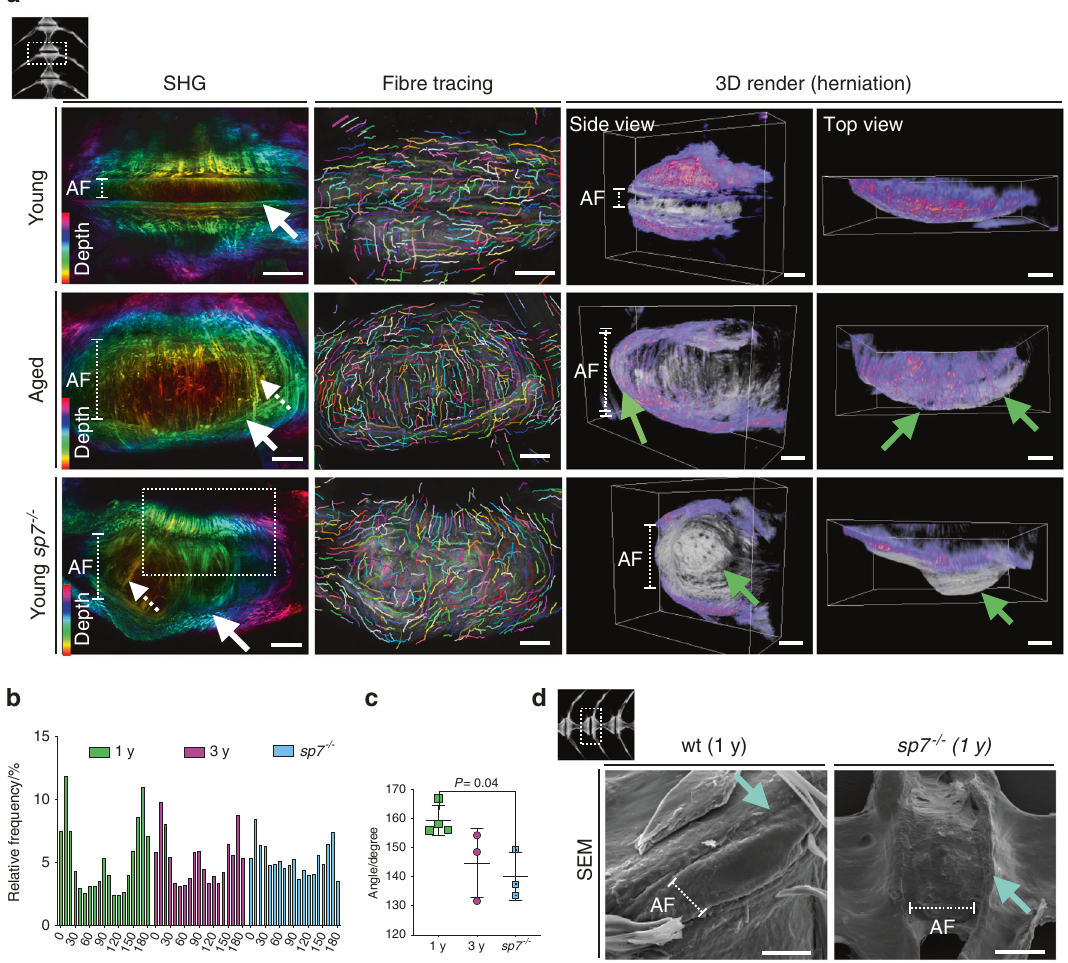
Fig. 6 Altered collagen fi ber organization and disc herniation in zebra fi sh IVDD. a Max projection of image stacks from second harmonic generation (SHG) imaging color coded by depth. Individual collagen fi ber was traced using CTFire. 3D volumetric rendering from SHG images were used to visualize disc herniation in 3D using Amira (gray = back-scatter SHG; purple = forward-scatter SHG). Orientation of the vertebral column is shown at the top left of the panel. The annuls fi brosus (AF) is indicated with a dashed line. Note the variation in AF length among the groups. Smooth perpendicular fi ber organization at the endplate was observed only in young samples (white arrow, SHG). Thicker fi bers were observed in the AF of aged and sp7 − / − zebra fi sh (dashed arrow). Bulging discs were found in aged zebra fi sh and severely bulging discs were found in sp7 − / − zebra fi sh (green arrows, 3D render). Scale bars = 50 μ m. b Relative frequency distribution (%) of angles of collagen fi bers from each group. The graph was generated in Prism 8. c Angle of the most common collagen fi bers (75% of total fi bers) show abnormal orientation in sp7 − / − fi sh ( n = 3 fi sh per group). One-way ANOVA, post hoc Tukey ’ s multiple comparisons test; data are the mean and SD. P values are indicated when signi fi cant ( P < 0.05). d Scanning electron microscopy (SEM) of 1-year-old wt and sp7 − / − zebra fi sh (1 y). Note a smooth transition from the vertebral bone to the AF in wt zebra fi sh and a cliff in sp7 − / − zebra fi sh (arrow). The orientation of the vertebral column is shown on the top left. Scale bars = 50 μ formed by a layer of cartilage under different differentiated axis. As zebra fi sh swim through a viscous medium, the distribution statuses, the bony endplates in zebra fi sh are in direct contact with of load in the zebra fi sh spine is axial, similar to bipeds, including the collagenous notochord sheath layer; thus, the translational humans 39 . The loss of notochordal cells in humans is associated interpretation from phenotypic assessment of the region to with NP degeneration and IVDD 64 . Zebra fi sh have persistent humans is not direct and should be considered. notochordal cells in the IVD 65 , which can be disadvantageous Calci fi cation of IVDs is part of the degeneration phenotype of when modeling human IVDD; however, persistent notochordal IVD. Calci fi cation has been reported in 60% of elderly human cells are common in most animal models of IVDD 63 . Interestingly, cadavers 66 and is also detected in dogs, sheep and mice 67 . Recent we demonstrated IVDD to be accompanied by the loss of notochordal cells and fi brosis, similar to the outcomes in humans, studies have demonstrated that disc calci fi cation is dependent on suggesting an important role of vacuolated cells in preventing genetic background 67 . Our results indicate that calci fi cation is also degeneration. The ability to generate mutants in a genetically part of zebra fi sh IVDD and associated with genes involved in bone tractable zebra fi sh model can enable the identi fi cation of key formation and remodeling, as we detected calci fi cation in nearly molecular players controlling cellular modi fi cation within the NP 80% of aged spines and in younger zebra fi sh showing misalign- during aging, which can in turn help to disentangle potential ments; severe calci fi cation was observed in zebra fi sh carrying genetic factors of IVDD. Another limitation of our model is the lack mutations in sp7 and cathepsin K . Disc calci fi cation is observed in of cartilaginous endplates. Whereas the endplates in mammals are other zebra fi sh mutants linked to collagenopathies, such as